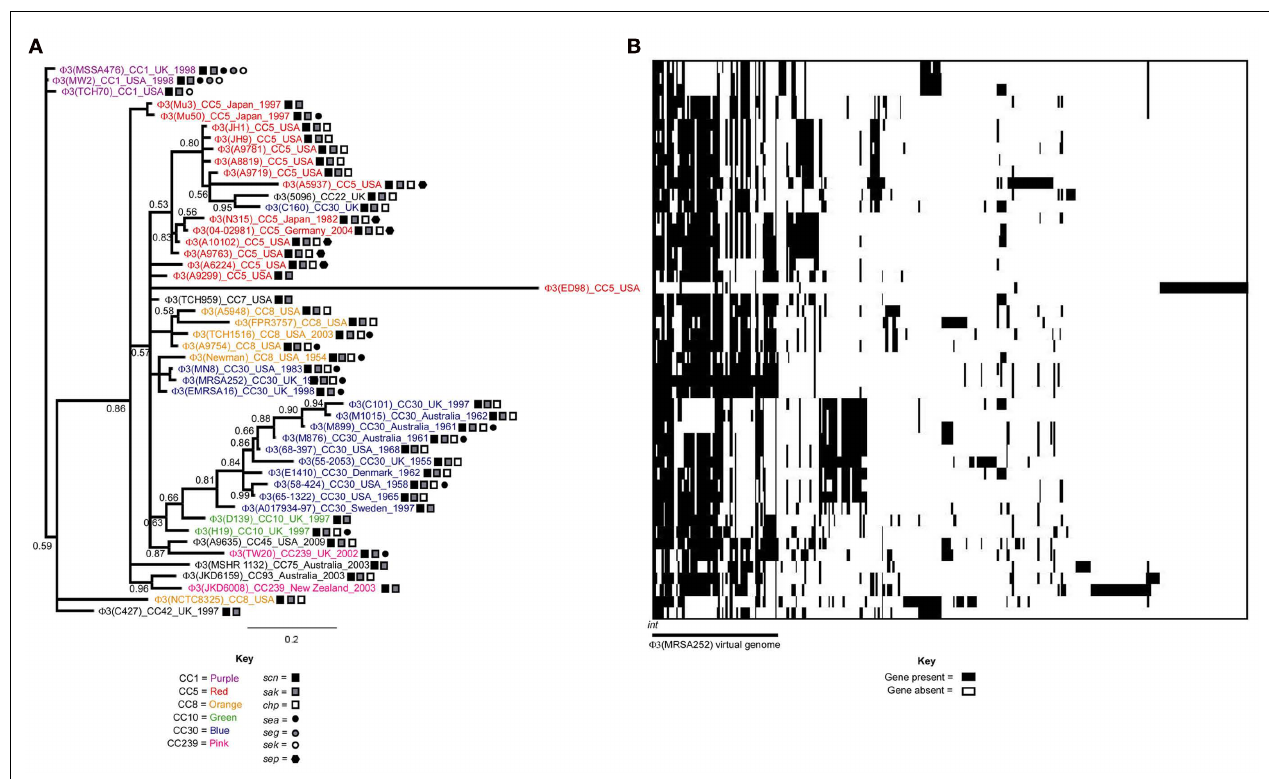
distribution of the virulence genes chp , sak , scn , sea , seg , sek , and sep is additionally mapped onto the phylogeny. (B) Presence/absence of 324 ϕ 3 genes is shown for each of the ϕ 3 prophage. Each horizontal line represents the genome of the adjacent ϕ 3 prophage in the phylogeny. Each vertical line represents a ϕ 3 gene.The color in the middle depicts if the gene is present (black) or absent (white).The genes are organized into virtual genomes, and the first genome shown in ϕ 3